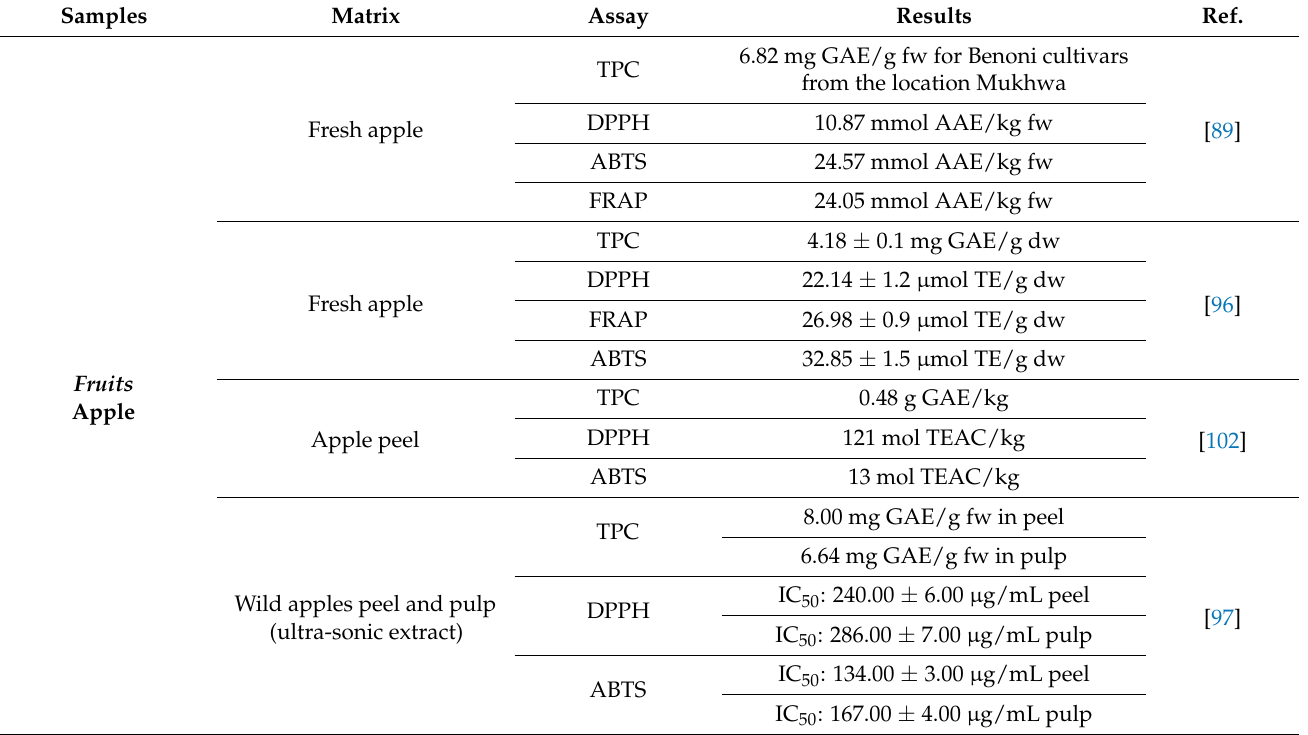
Table 2. Variations in the in vitro antioxidant activity for six prominent groups of food and related products that are consumed globally: fruits (apple and berries), vegetables (spinach and olives), processed products (wine, coffee, and tea), dairy products (milk and yogurt), legumes (soybeans, beans), and grains (wheat and corn), as documented in peer-reviewed published literature. Samples Matrix Assay Results Ref.